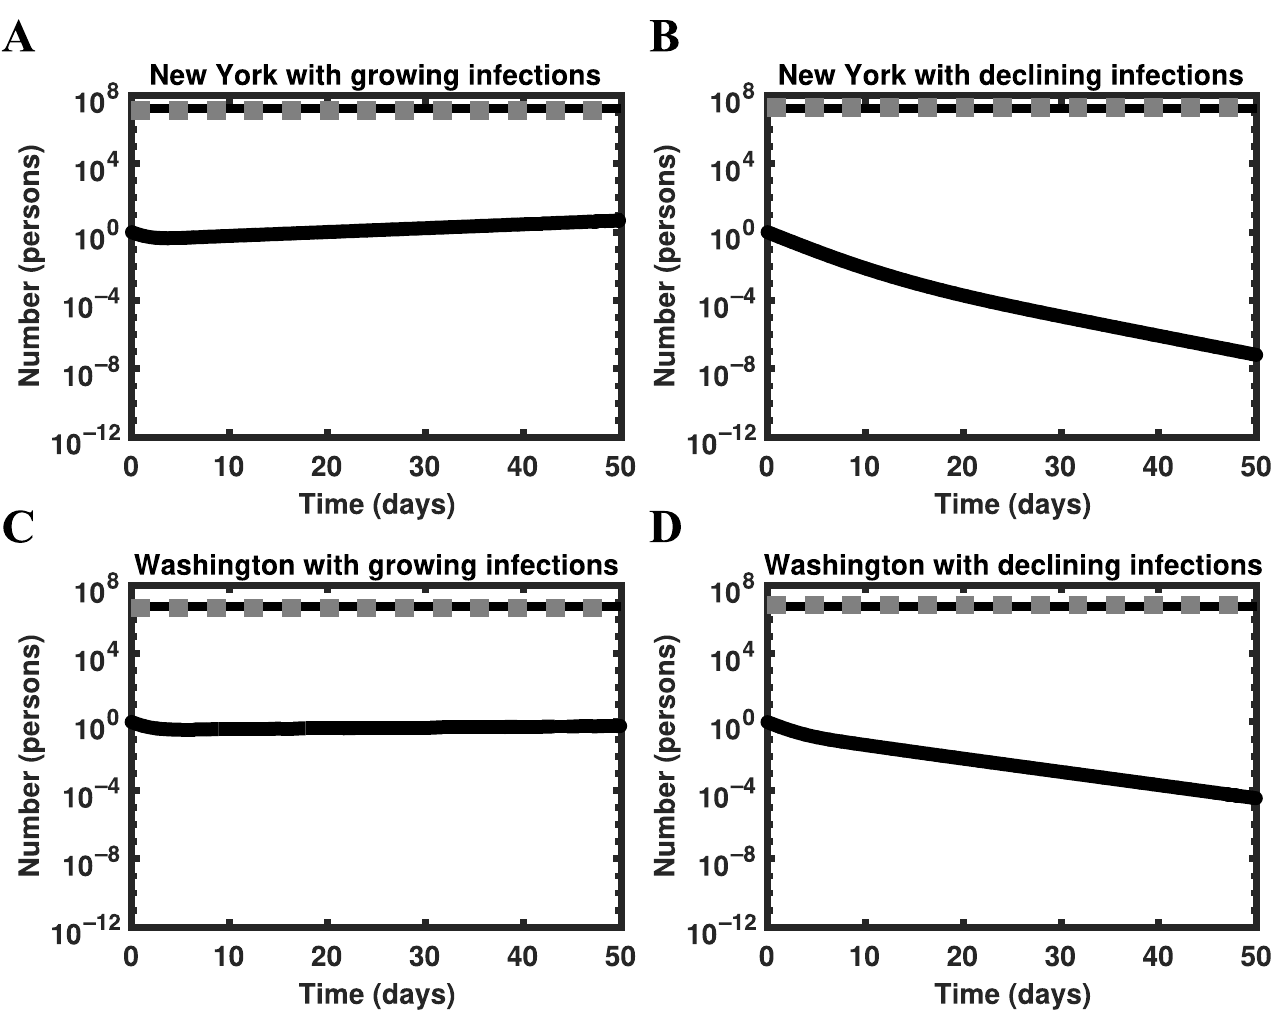
Figure 6. Perturbation analysis using the full model of Lin et al. [22] for the states of New York (panels A and B ) and Washington (panels C and D ). In each panel, the black solid line represents the number of infectious persons (initially 1), the black broken line represents the threshold number of persons required for herd immunity (i.e., 𝑆 ℎ ), and the gray broken line represents the number of recovered persons (initially 𝑆 ℎ − ε , obtained as described in Results). Simulations are based on MAP estimates for model parameters obtained using surveillance data collected from 21 January to 21 June